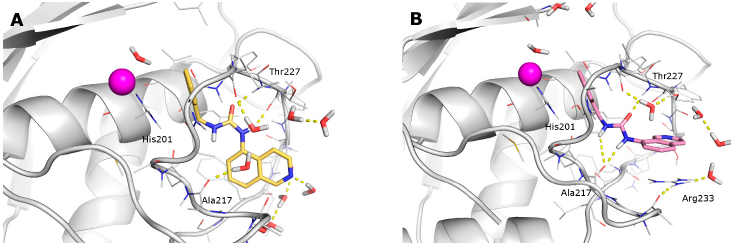
Figure 8. Binding poses of 1h ( A ) and 1i ( B ) obtained from the last 90 ns of the MD trajectory. MMP-2 is represented as a grey cartoon and ligands as sticks. H-bonds are depicted as yellow dashed lines.